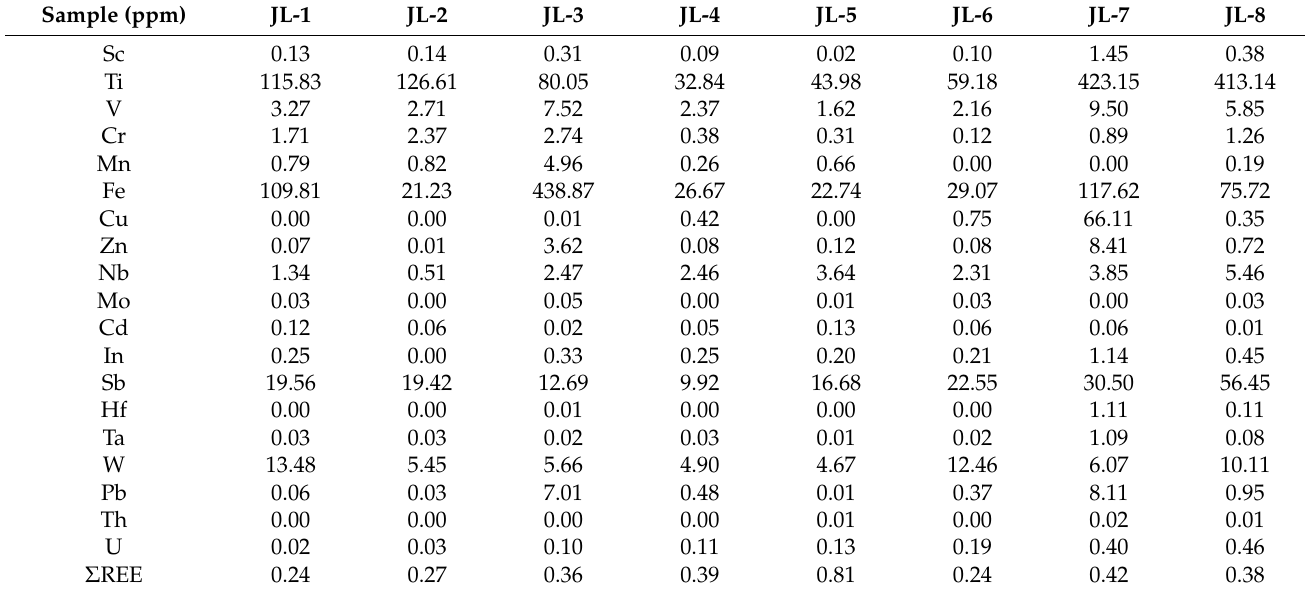
Table 2. LA–ICP–MS trace element data for cassiterite in the Jialong Sn–Cu deposit, comparative data for cassiterite from other deposits are presented in Table